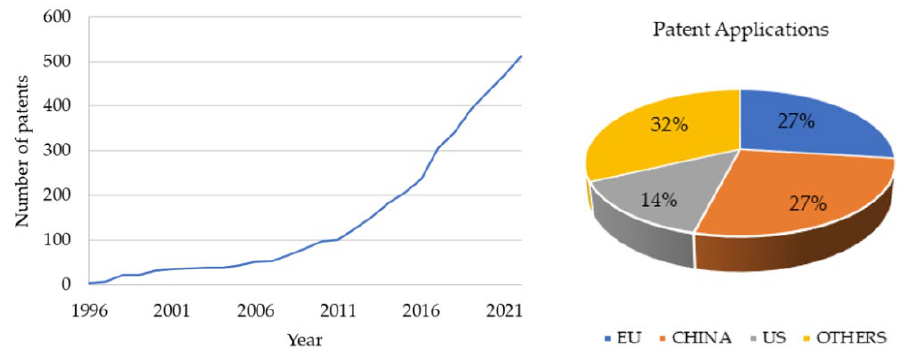
Figure 2. Number of patents over the past few years and percentages of patent registrations in different countries.